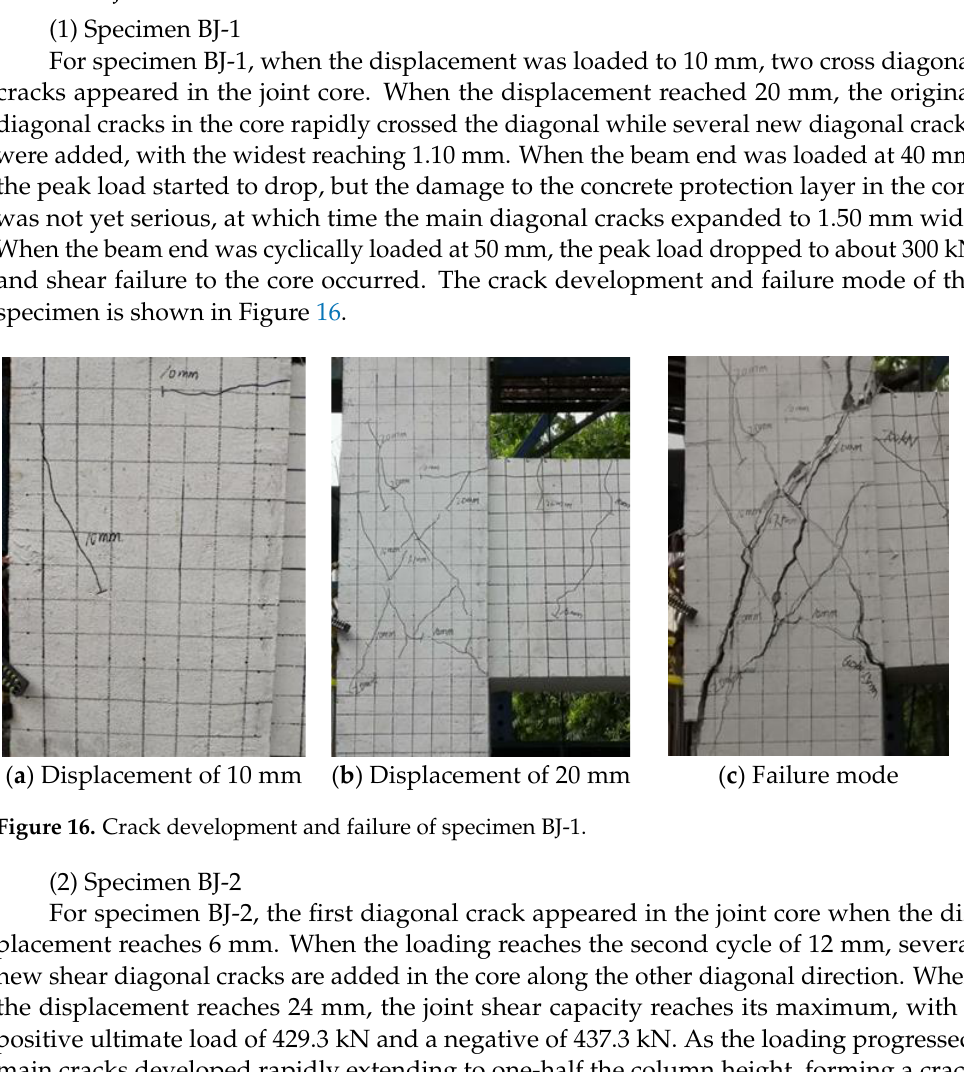
Figure 15. Crack development and failure of specimen ZJ-4.